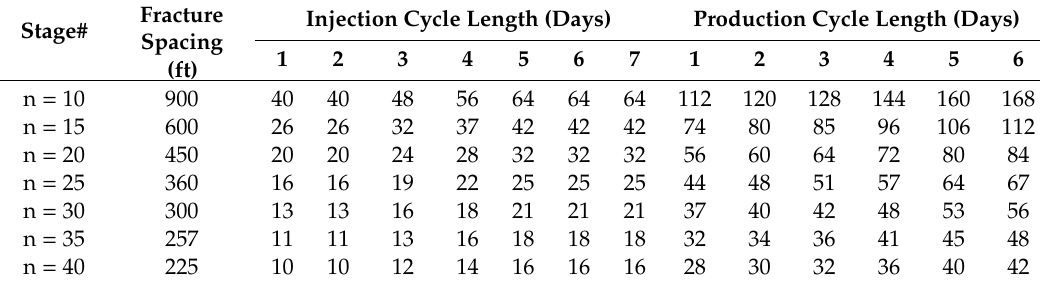
Table 1. Injection and Production Cycle Sizes.